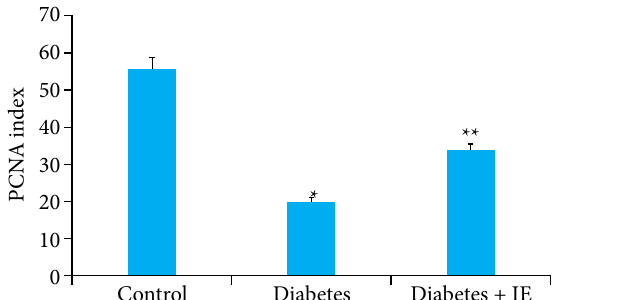
Figure 5 – PCNA index of control, diabetes, and diabetes+IE groups. *p < 0.001 compared to diabetes group; **p < 0.01 compared to diabetes+IE group.